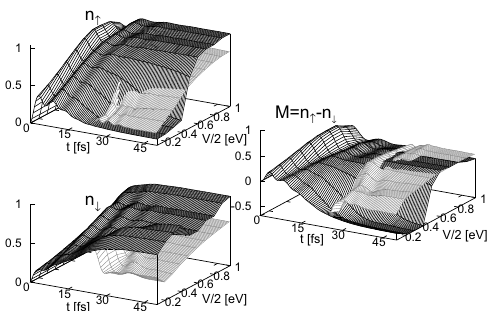
Fig. 2. Island level occupancies and island magnetization (their di ff erence) as a function of time and the bias. Darker surface: At t 0 = 0 the left lead is suddenly attached. Lighter surface: at t = 25 f s the right lead is additionally attached. U = 0 . 6 eV , the bias voltage V is varied and serves as the second axis of all plots.